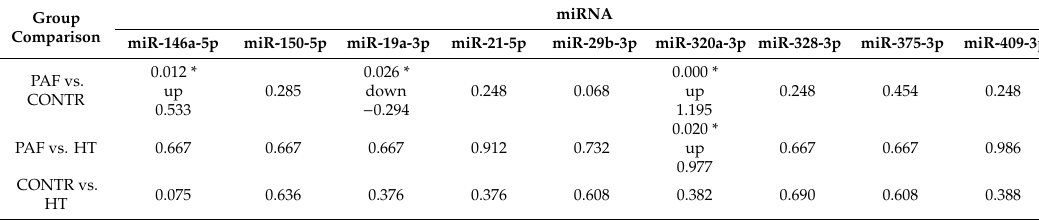
Table 3. Multiple linear regression (MLR) p -values for a comparison of miRNA relative plasma levels in the study sample groups: PAF: 30 PAF patients; HT: 30 hypertensive patients without AF; CONTR: 30 healthy controls. The asterisks (*) indicate statistically significant di ff erences ( p < 0.05). For